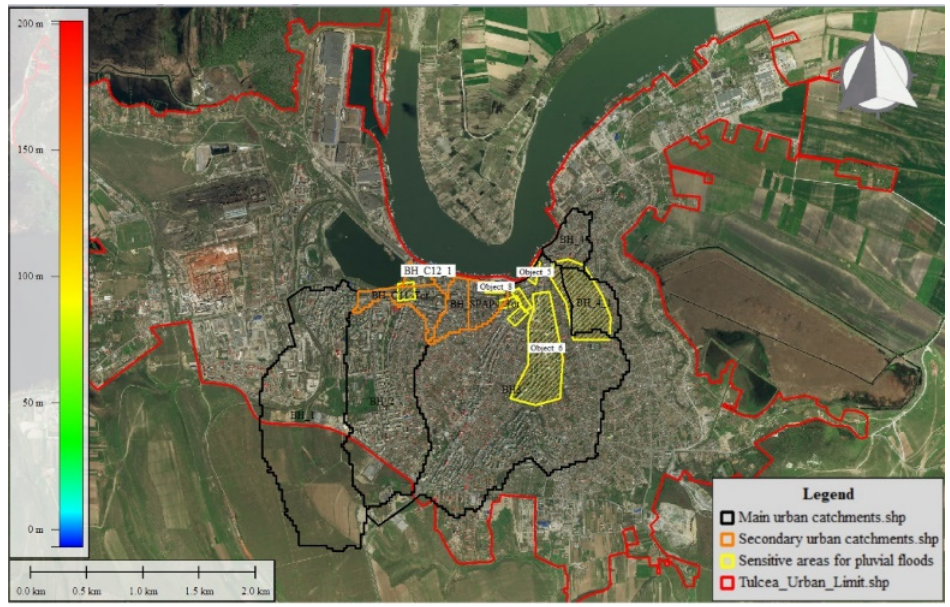
Figure 10. Urban catchments and frequently flooded areas.